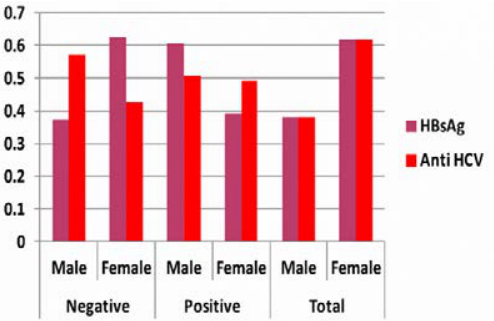
Fig. 2. The gender-wise proportion of submitted samples and the summary of HBsAg and Anti-HCV